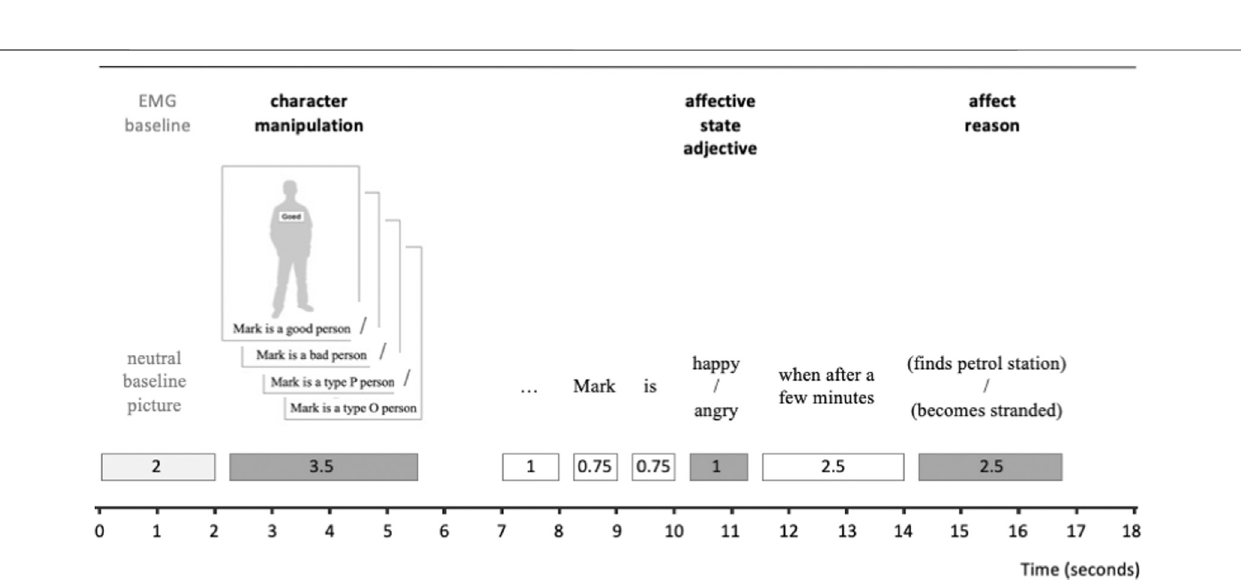
Frontiers in Communication |